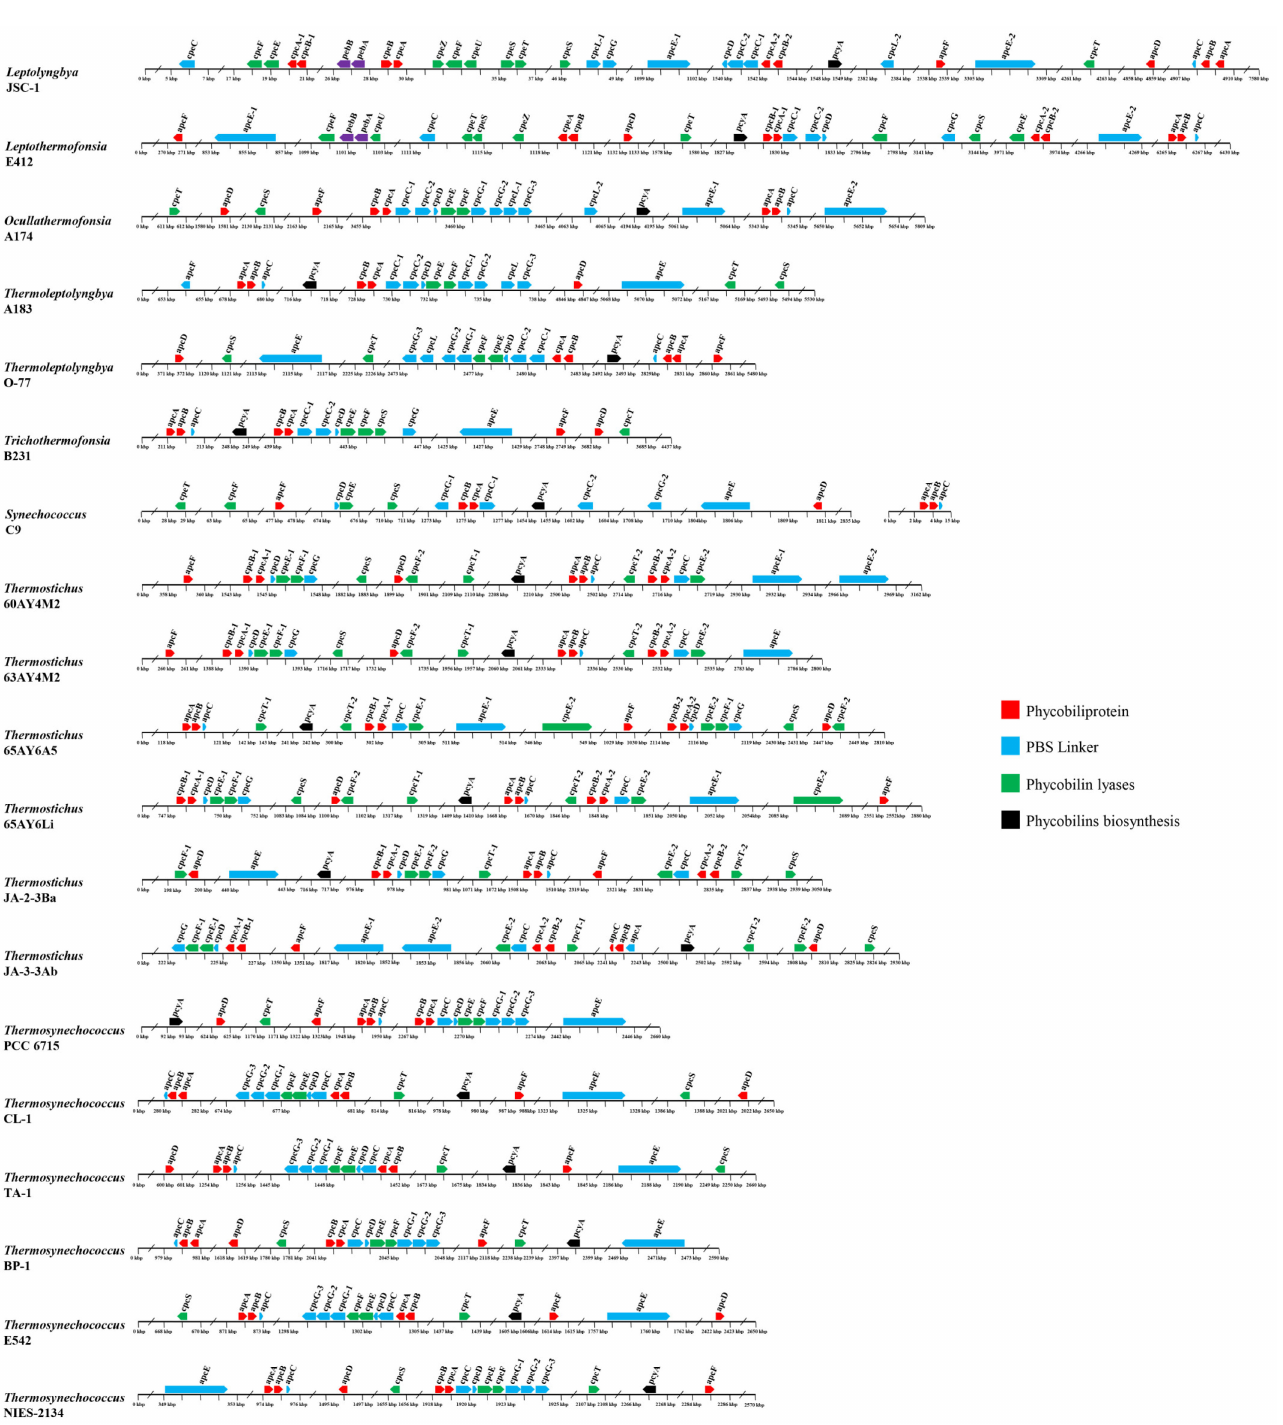
Figure 6. Genomic organization of PBS-related genes in the 19 thermophilic cyanobacteria surveyed. Solid arrow boxes refer to genes and the direction of